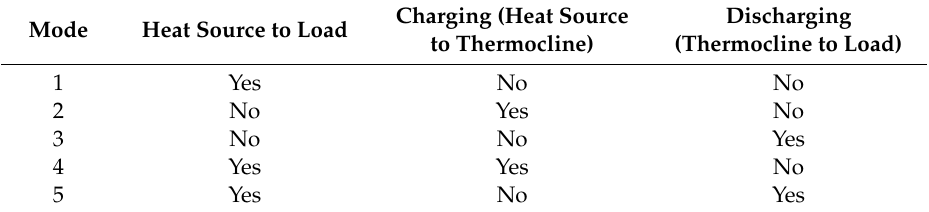
Table 3. Foreseeable operating modes.